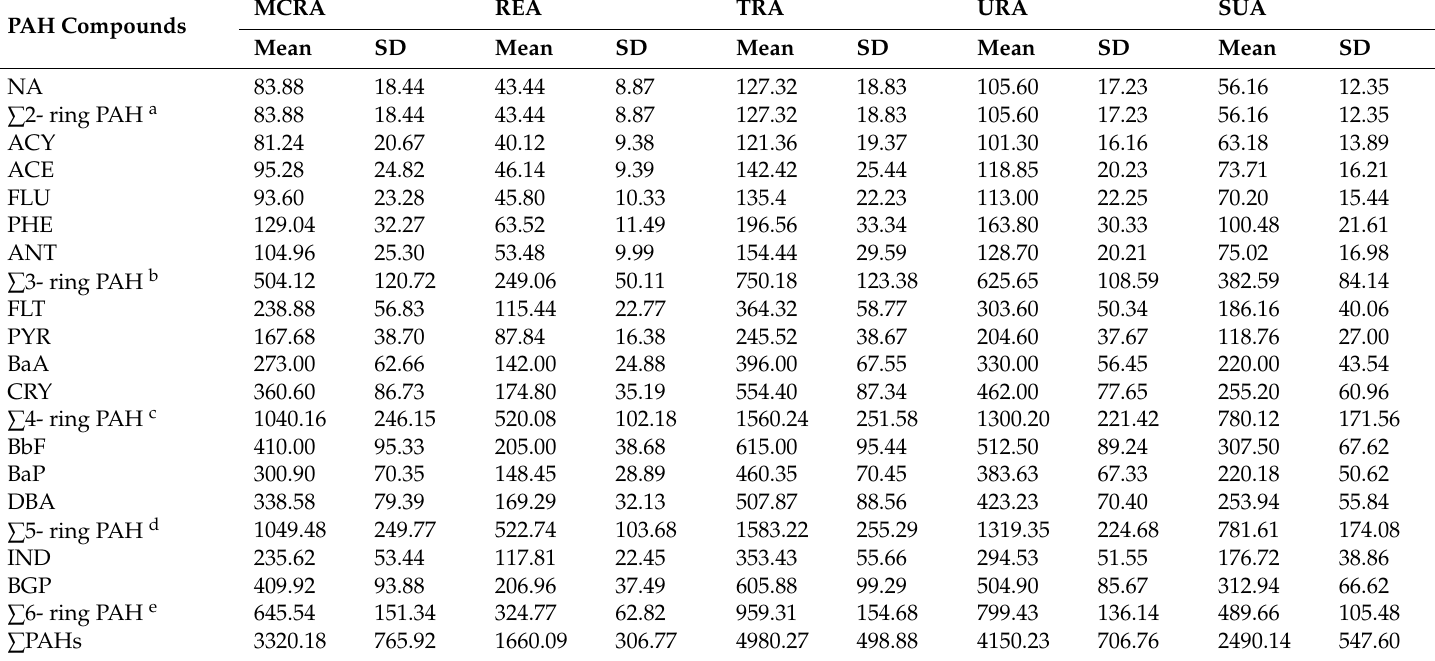
Table 2. The concentrations (ng/g) of the individual PAH compounds and different categories of PAHs based on aromatic ring number in street dusts collected from the different areas of Jeddah